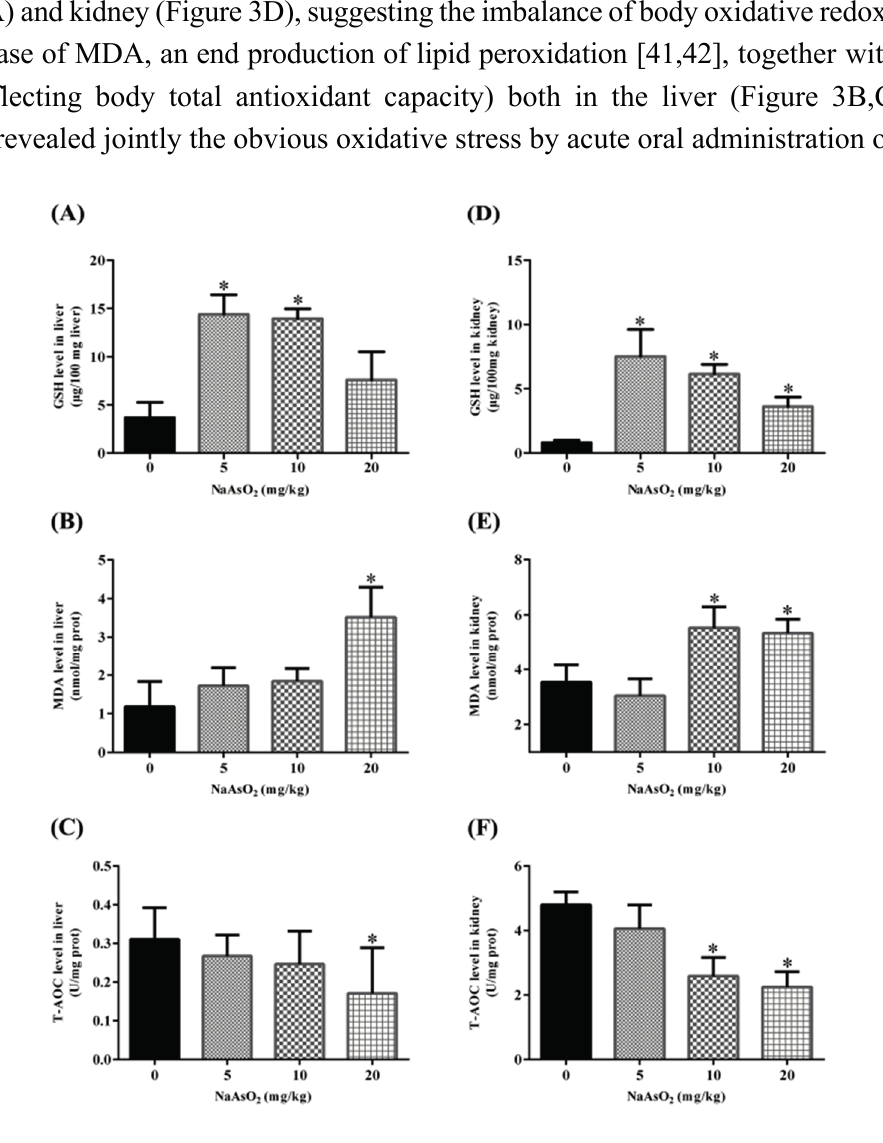
Figure 3. Effects of acute NaAsO 2 exposure on GSH, MDA and T-AOC levels in the liver and kidney of control and acute arsenic-exposed mice. Mice were treated with NaAsO 2 intra-gastrically for 24 h with indicated doses. The levels of GSH, MDA and T-AOC in the liver ( A – C ) and kidney ( D – F ) were all determined using commercially available kits as described in materials and methods. Data were presented with means ± SD (n =